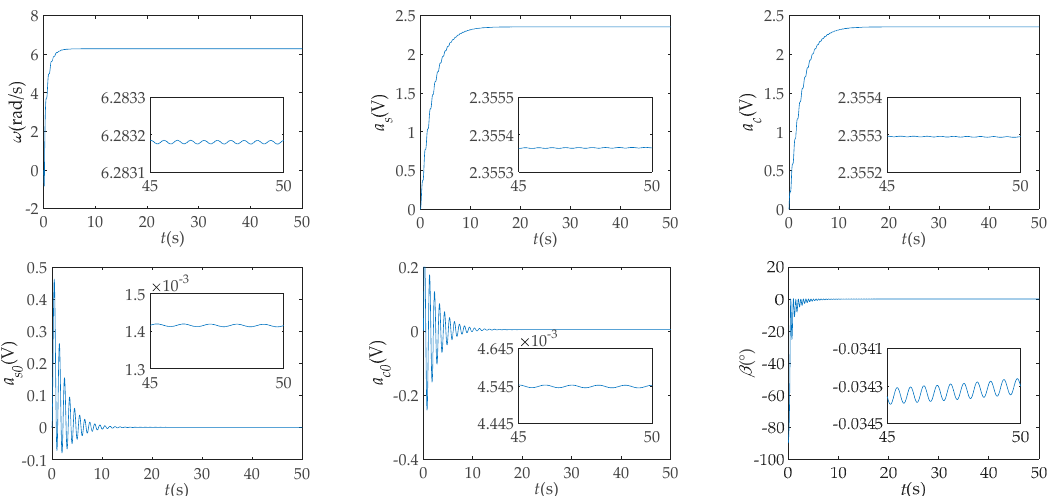
Figure 17. Estimations of angular velocity and imperfect parameters after the DWT-SVD based filter